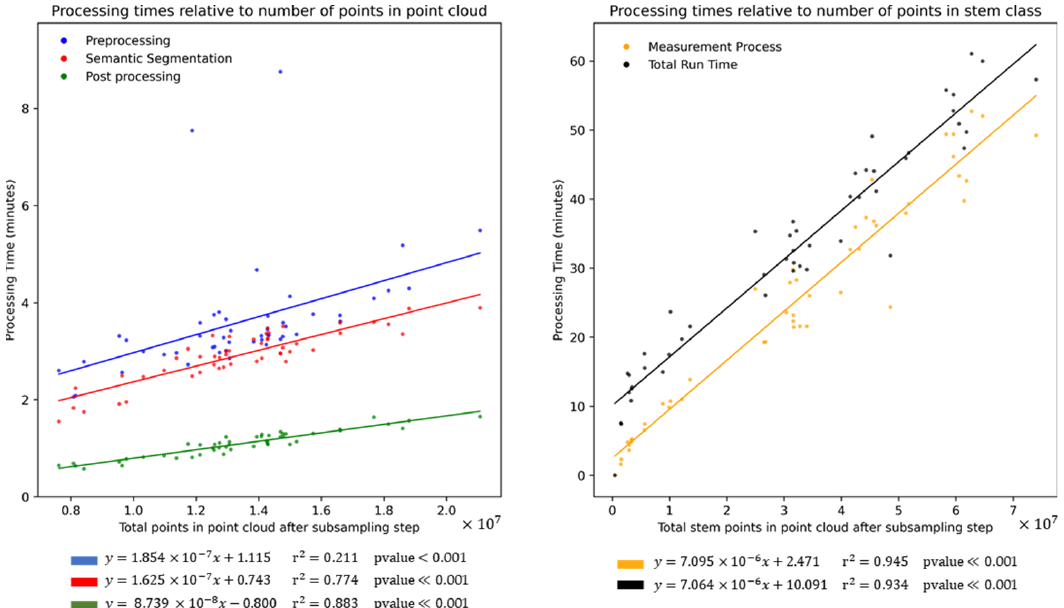
Figure 17. This figure shows the processing times of each main process in FSCT on the hardware specified in Section 2.6. Left shows the processing times for the pre-processing, deep learning based semantic segmentation, and post-processing steps relative to the total number of points in a point cloud. Right shows the total processing time and the measurement processing time relative to the number of stem points, as the measurement process is the most time-consuming process and primarily depends on the number of stem points.